Question: How would you classify this visualization?
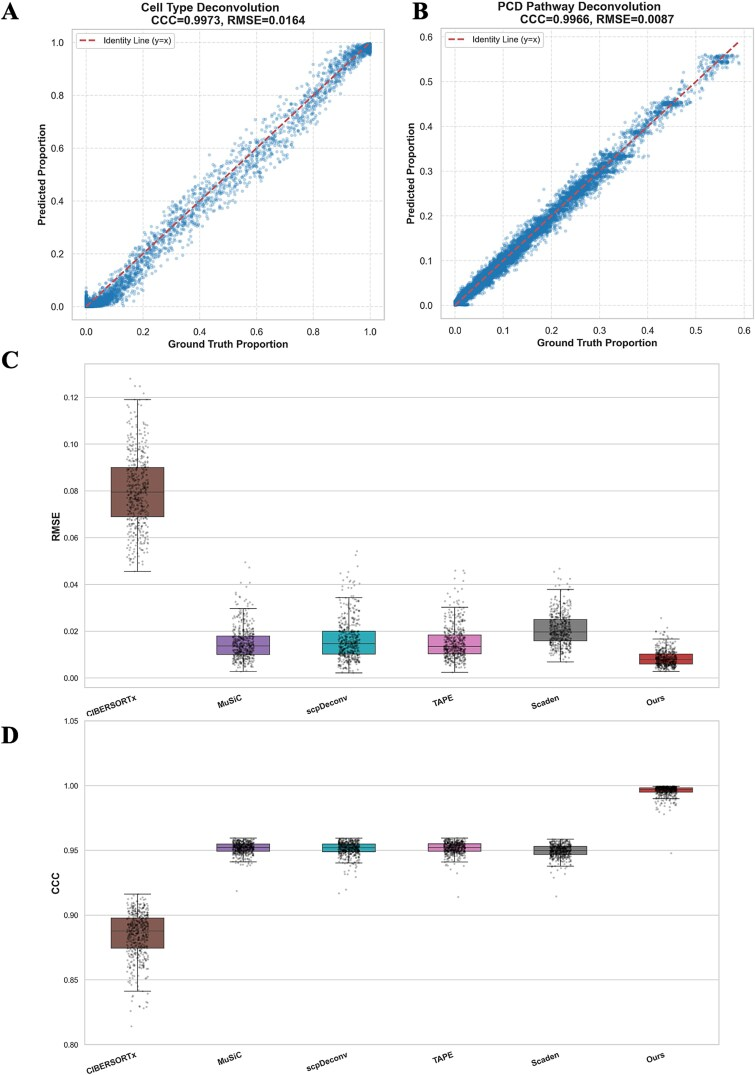
Answer: scatter